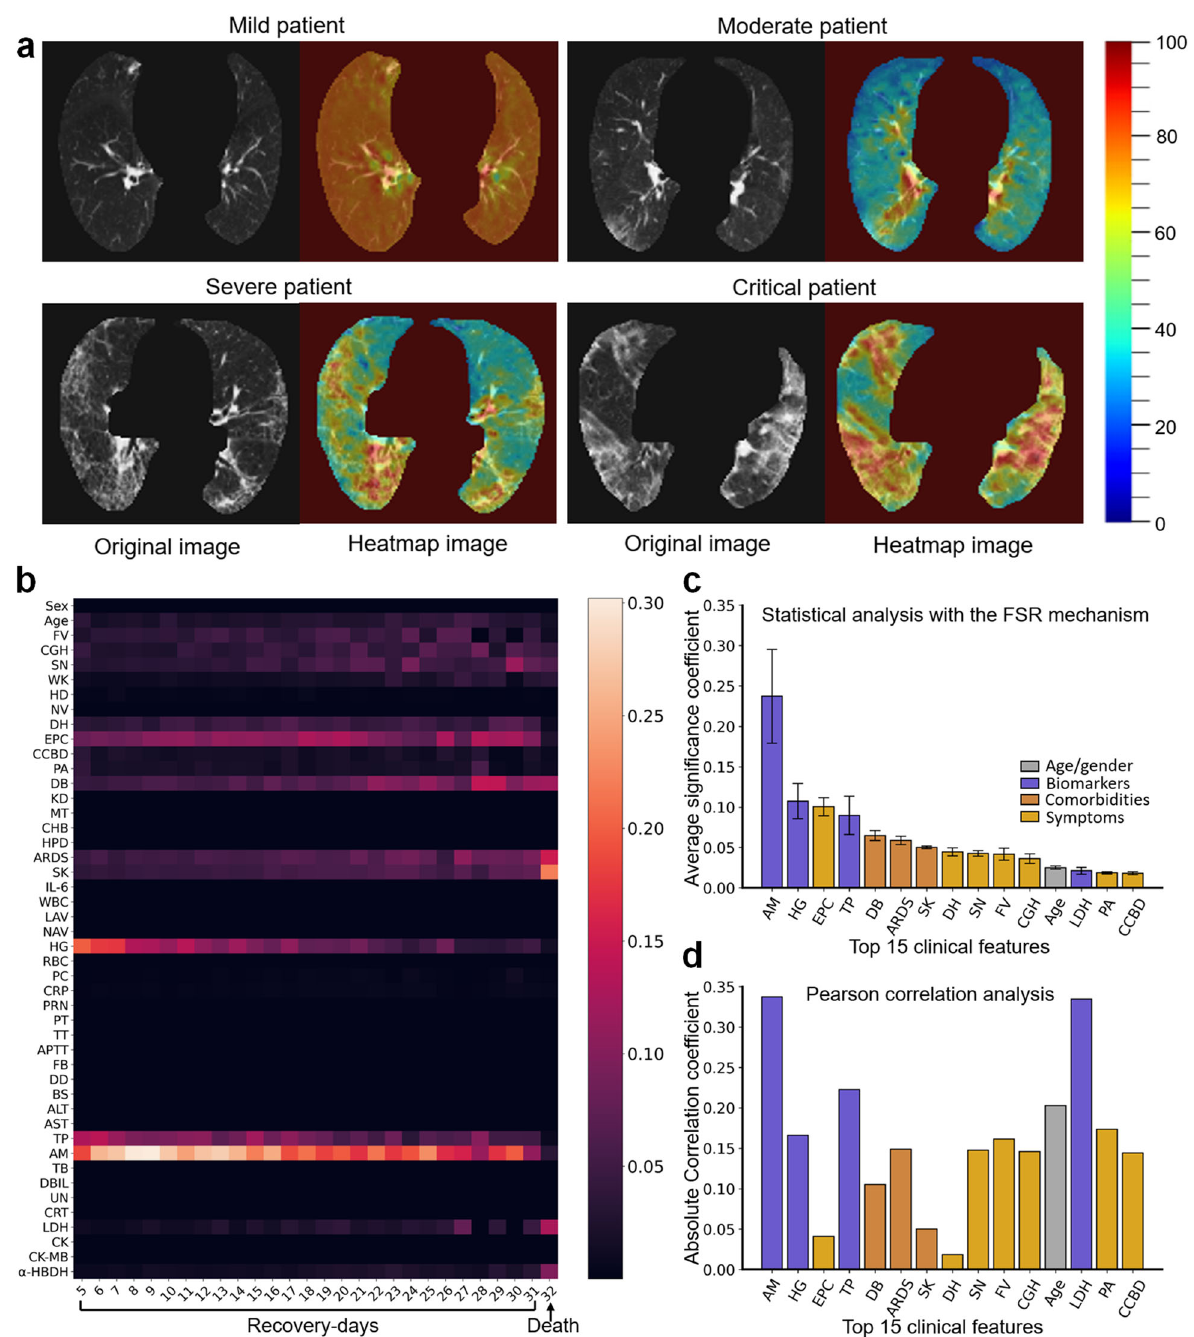
Fig. 5 Network visualization and statistics of the feature signi fi cance for the model prediction. a Feature map visualization of iCOVID corresponding to four representative patient examples (color masks the signi fi cant regions for the prediction, with the spectrum from blue to red associated with low-to-high signi fi cance). b Heatmap of the average signi fi cance of each feature and the recovery days, revealing that the biomarkers AM , TP , and HG are signi fi cant for the prediction of recovered patients, whereas the comorbidities SK , ARDS , and DB are more signi fi cant for the prediction of deceased patients (color indicates the signi fi cance of each feature for the prediction, with the spectrum from dark purple to yellowish-white associated with low-to-high signi fi cance). c The average signi fi cance of the top 15 clinical features, i.e., AM albumin, HG hemoglobin, EPC expectoration, TP total protein, DB diabetes, ARDS acute respiratory distress syndrome, SK shock, DH diarrhea, SN soreness, FV fever, CGH cough, LDH lactate dehydrogenase, PA poor appetite, CCBD chest congestion/breathing dif fi culty. d Pearson